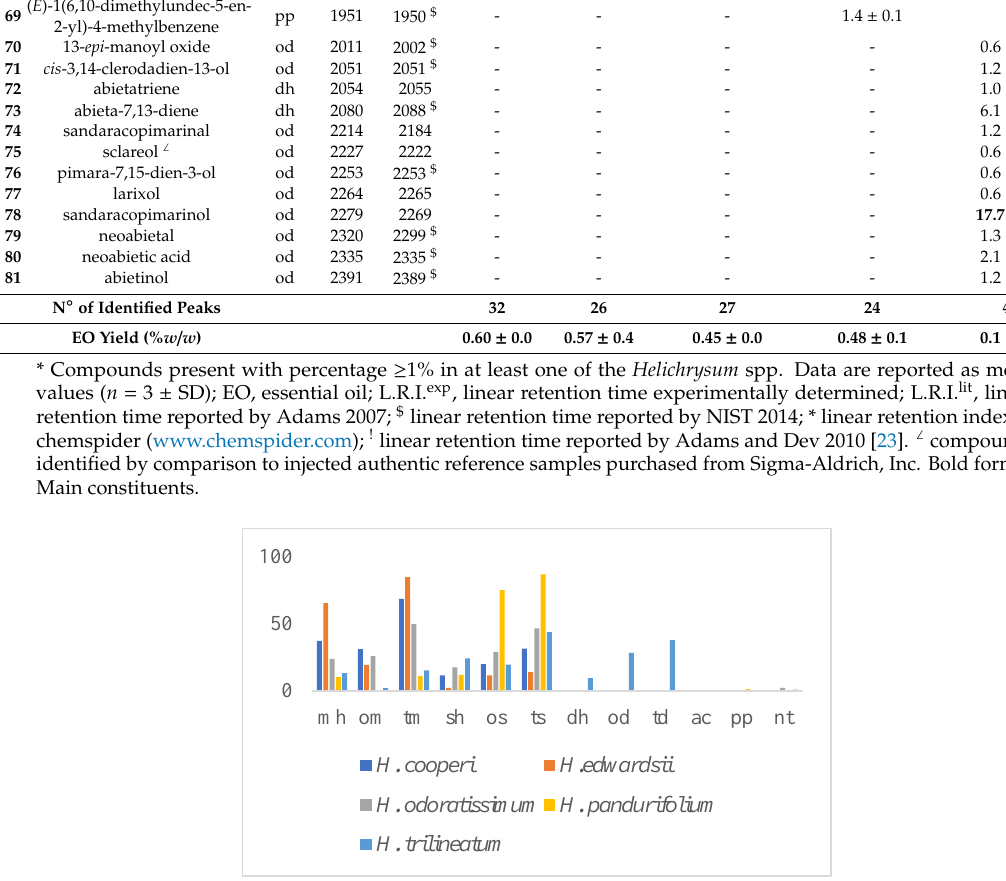
Figure 4. Variation of the class of compounds in the essential oils (EOs) of the studied Helichrysum spp. mh: monoterpenes hydrocarbons; om: oxygenated monoterpenes; tm: total monoterpenes; sh: sesquiterpene hydrocarbons; os: oxygenated sesquiterpenes; ts: total sesquiterpenes; dh: diterpene hydrocarbons; od: oxygenated diterpenes; td total diterpenes; nt: non-terpene derivatives. The exclusivity in a high amount of both trans and cis thujone (8.7% and 1.3%, respectively) in Table 4. Class of compounds in the essential oil of the studied Helichysum spp. H. edwardsii is Chemical Classes